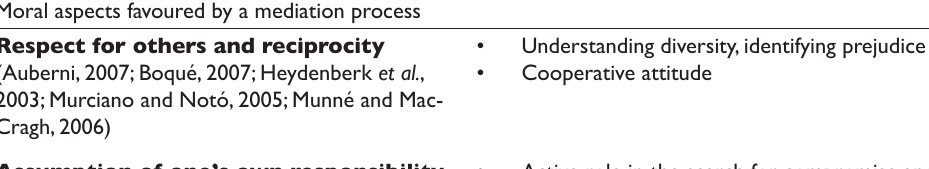
Table 2: Moral aspects favoured by a mediation process Moral aspects favoured by a mediation process Respect for others and